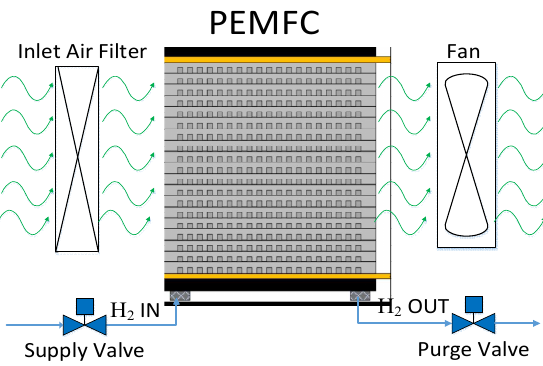
Figure 4. Diagram of the air-cooled PEMFC system.